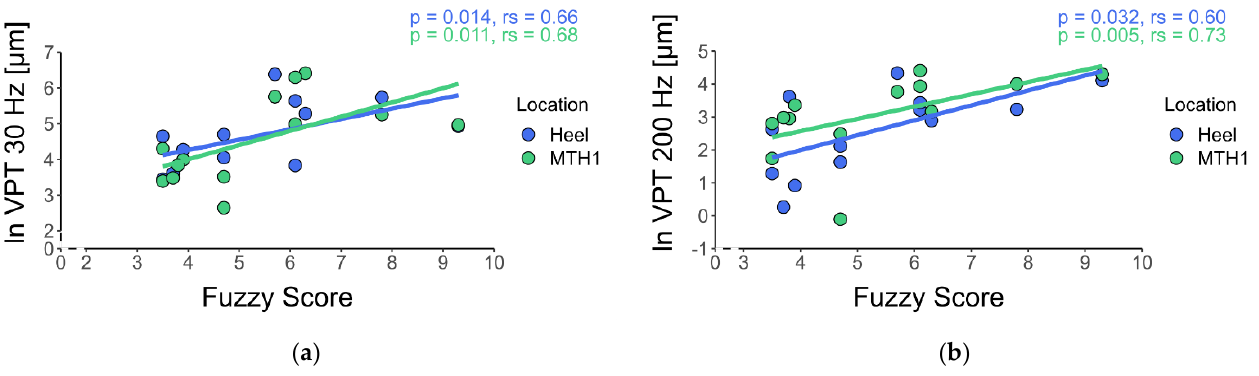
Table 2. Vibration perception thresholds for the control group (CG), diabetes group (DM), and DPN group (DPN) in µm for both frequencies and locations.